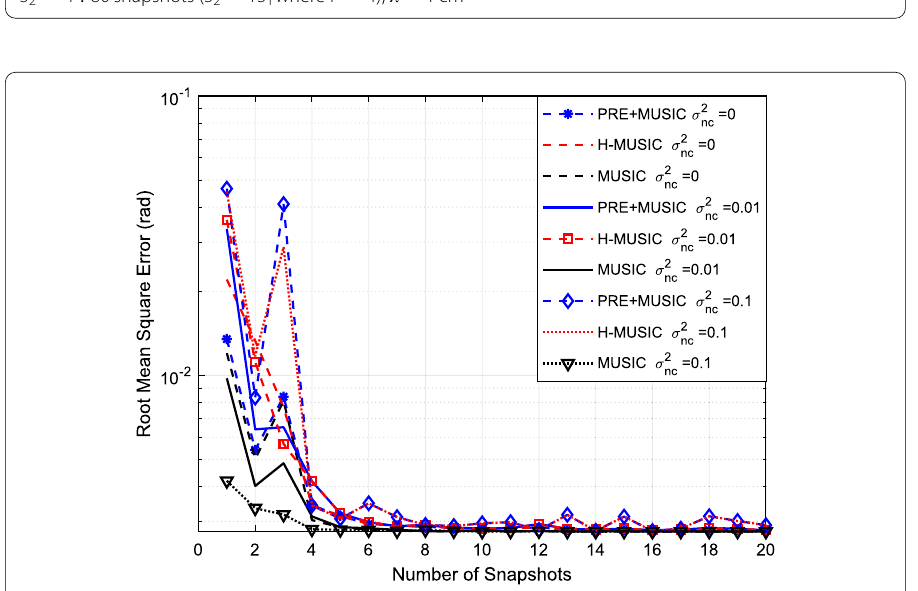
Fig. 8 RMSE of AoA estimation for the fully connected architecture, M c = 500 , SNR = 20dB , S 1 = 1 : 20 , S 2 = 4 : 80 snapshots ( S 2 = TS 1 where T = 4 ), (cid:31) =